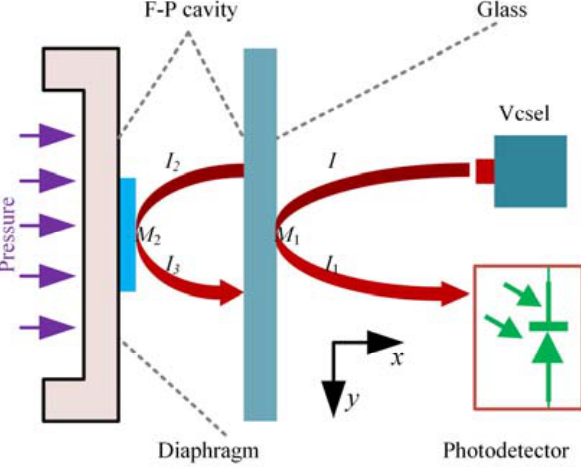
Figure 1. Schematic diagram of the optical cavity of the Fabry–Pérot pressure sensor. The diaphragm structure can be modeled as a thin membrane with four clamping edges. When the membrane is loaded with uniform pressure, the maximum deflection of the membrane is less than one-fifth of the membrane thickness [24], and the deflection of the membrane can be expressed as [25]: